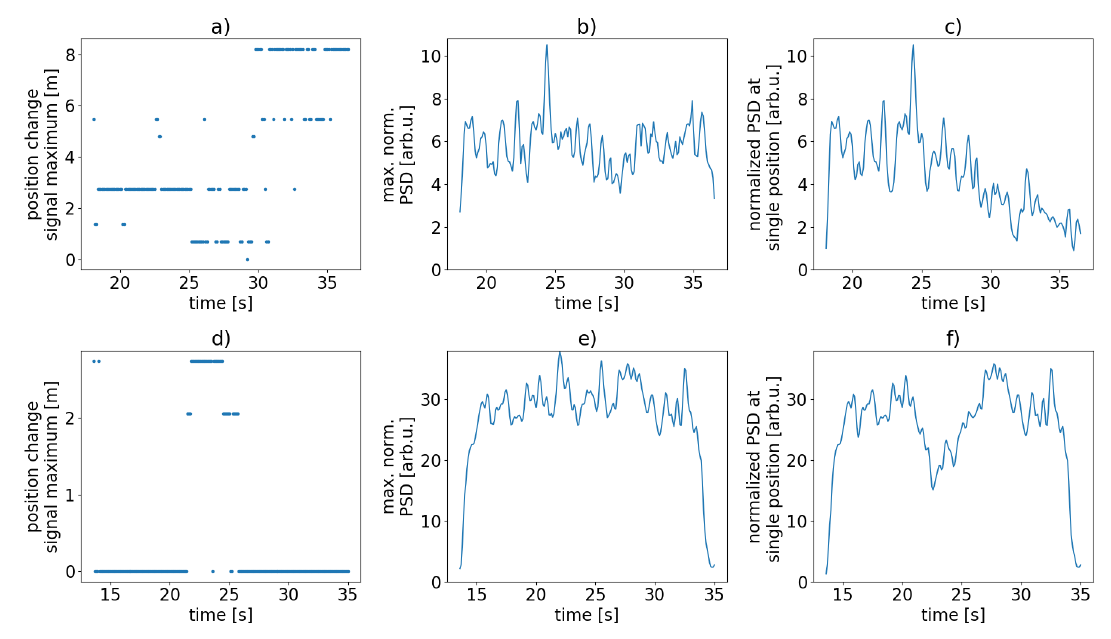
Figure 13. Measures showing sensitivity fading over time for the standard fiber ( a – c ) and for the scatterer fiber ( d – f ). ( a , d ) relative change of sensor position with the maximum signal strength (normalized PSD sum, Equation (8)); ( b , e ) corresponding signal strength; ( c , f ) signal strength in a single sensor range bin over time. Note the different